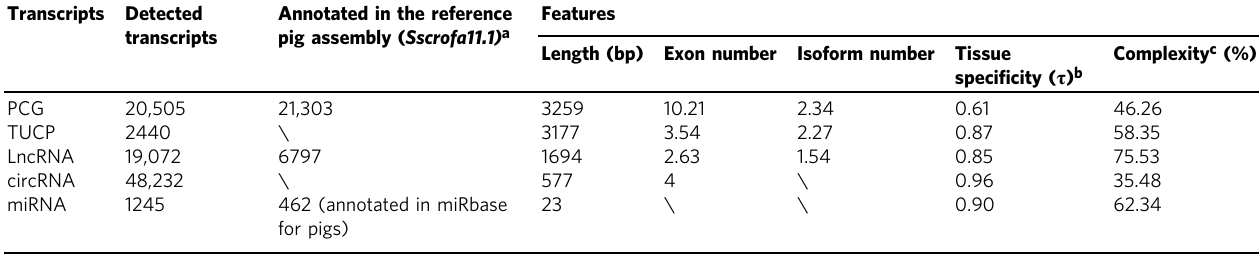
Table 1 The expanded pig transcriptome. Transcripts Detected Annotated in the reference transcripts pig assembly ( Sscrofa11.1) a